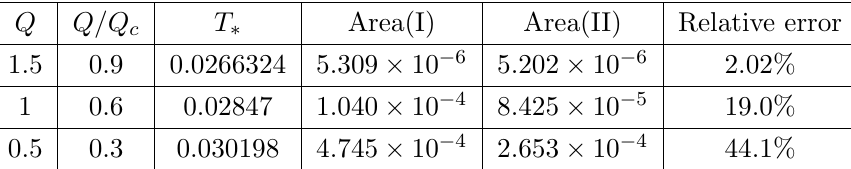
Table 1 . Failure of the equal area law in the T (cid:0) S E plane in d = 4 . In this table l = 10 and Q c = 5 = 3. We see that as we move further from criticality, the relative error between Areas I and II increases and the equal area law does not hold. The plots of the results can be found in (cid:12)gure